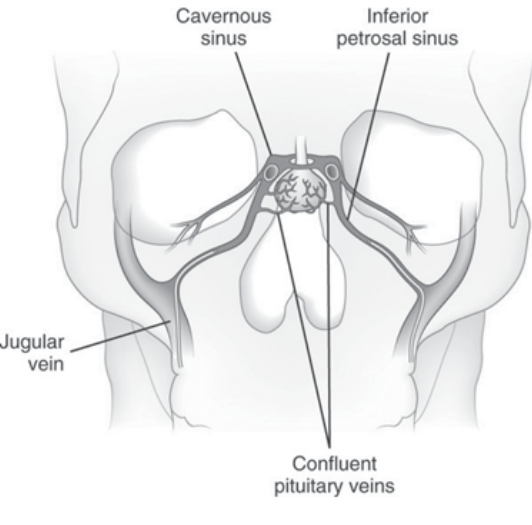
Figure 1. Anatomy of the venous drainage of the pituitary gland